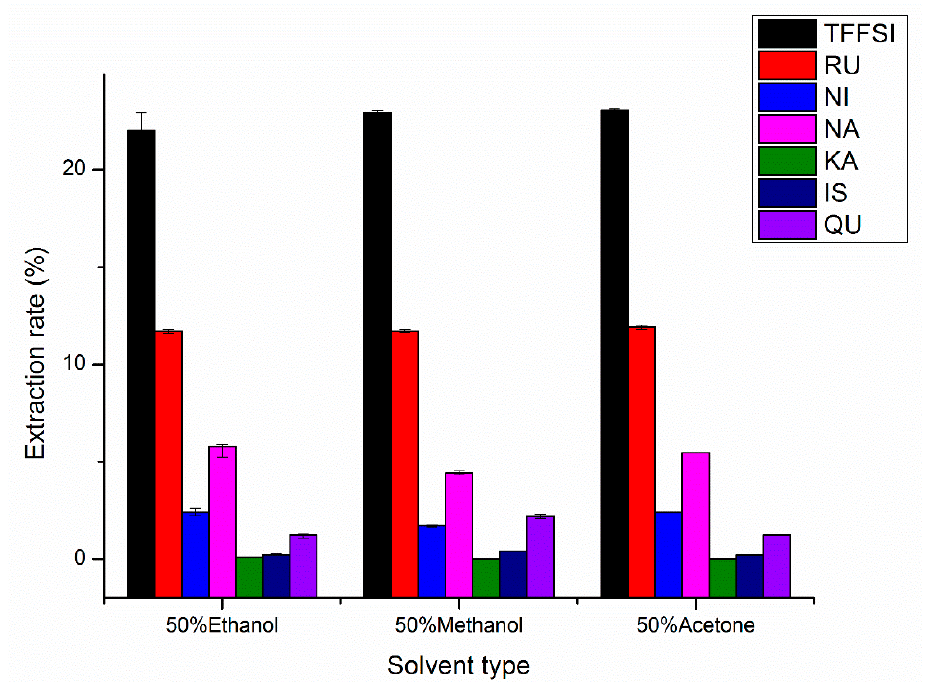
Figure 1. Effects of the solvent type on the extraction rates of rutin (RU), nicotiflorin (NI), narcissoside (NA), kaempferol (KA), isorhamnetin (IS), quercetin (QU), and the total flavonoids of Flos Sophorae Immaturus (TFFSI).